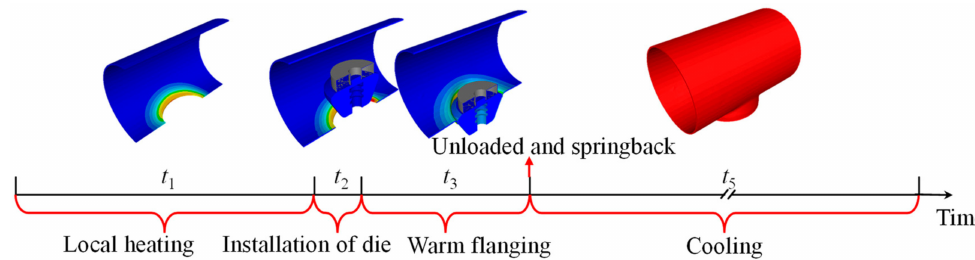
Figure 2. Through-process of heating-forming-cooling for manufacturing GIS